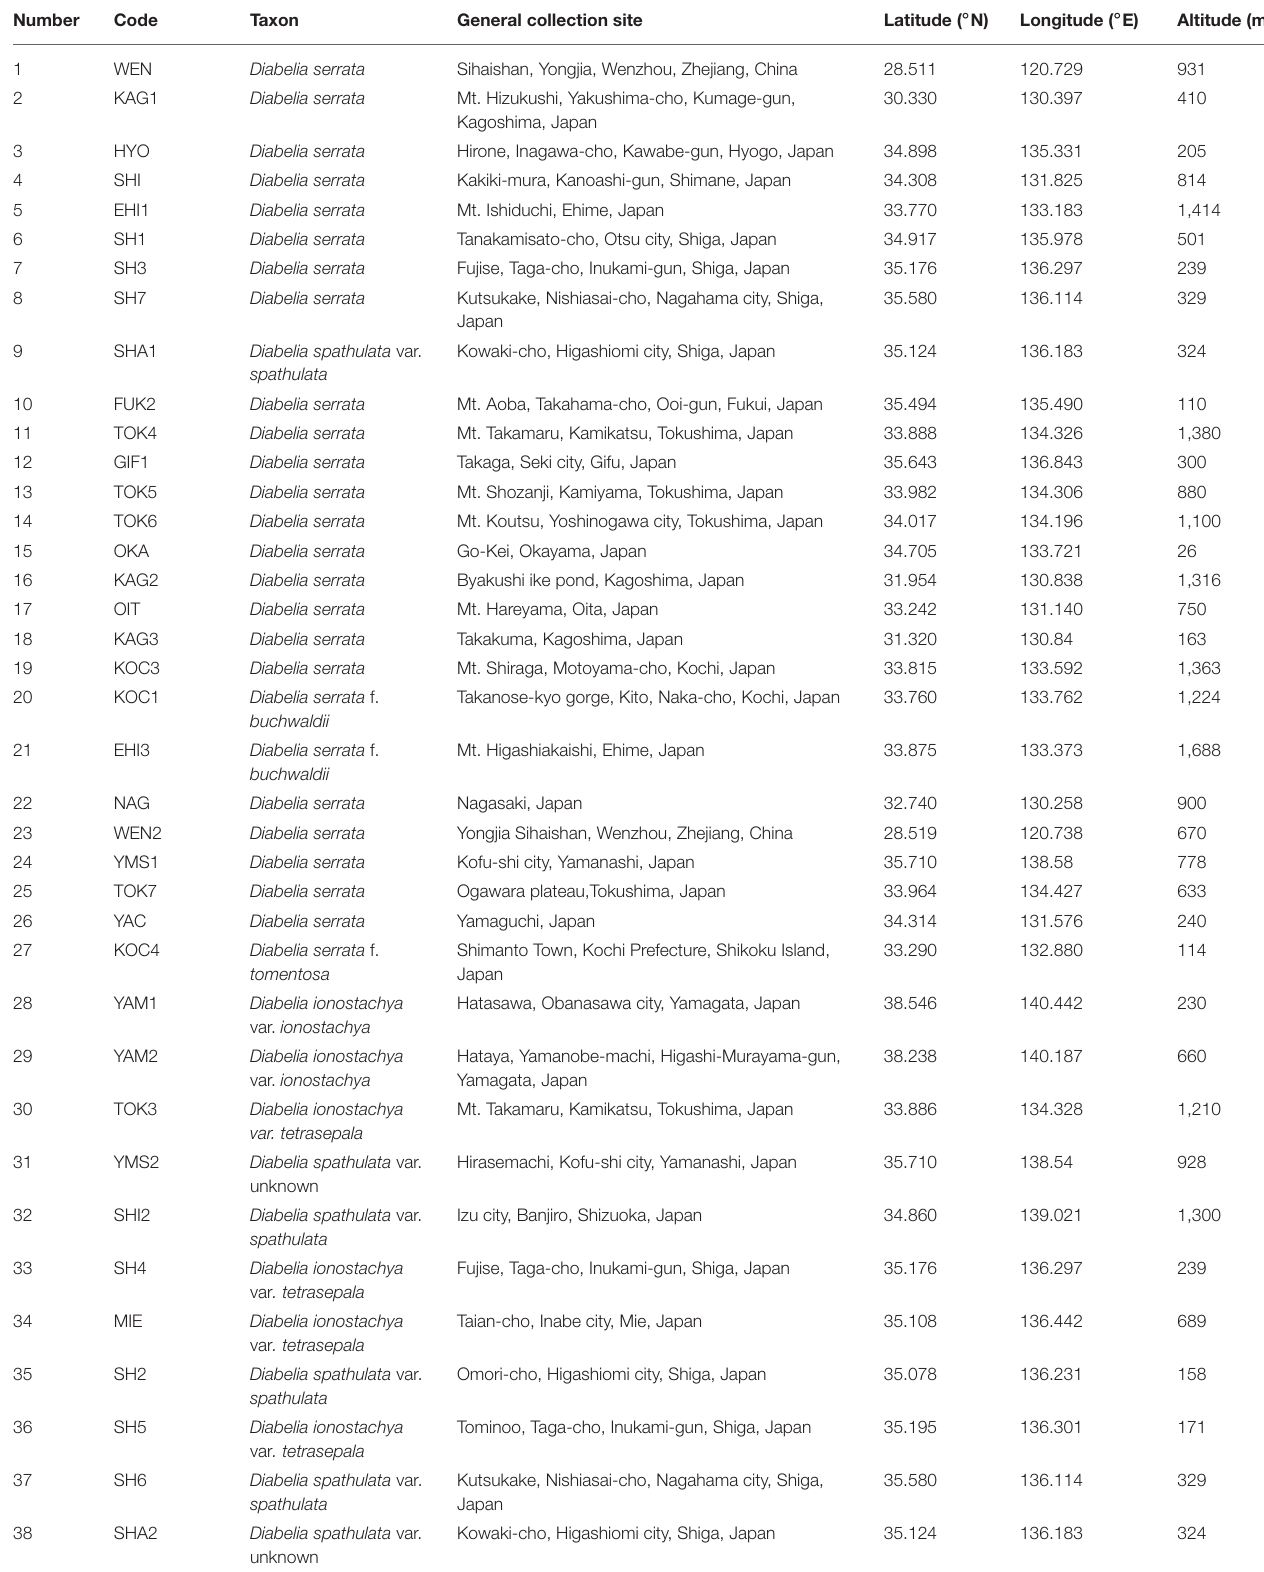
TABLE 1 | Details of sampled populations of Diabelia included in this